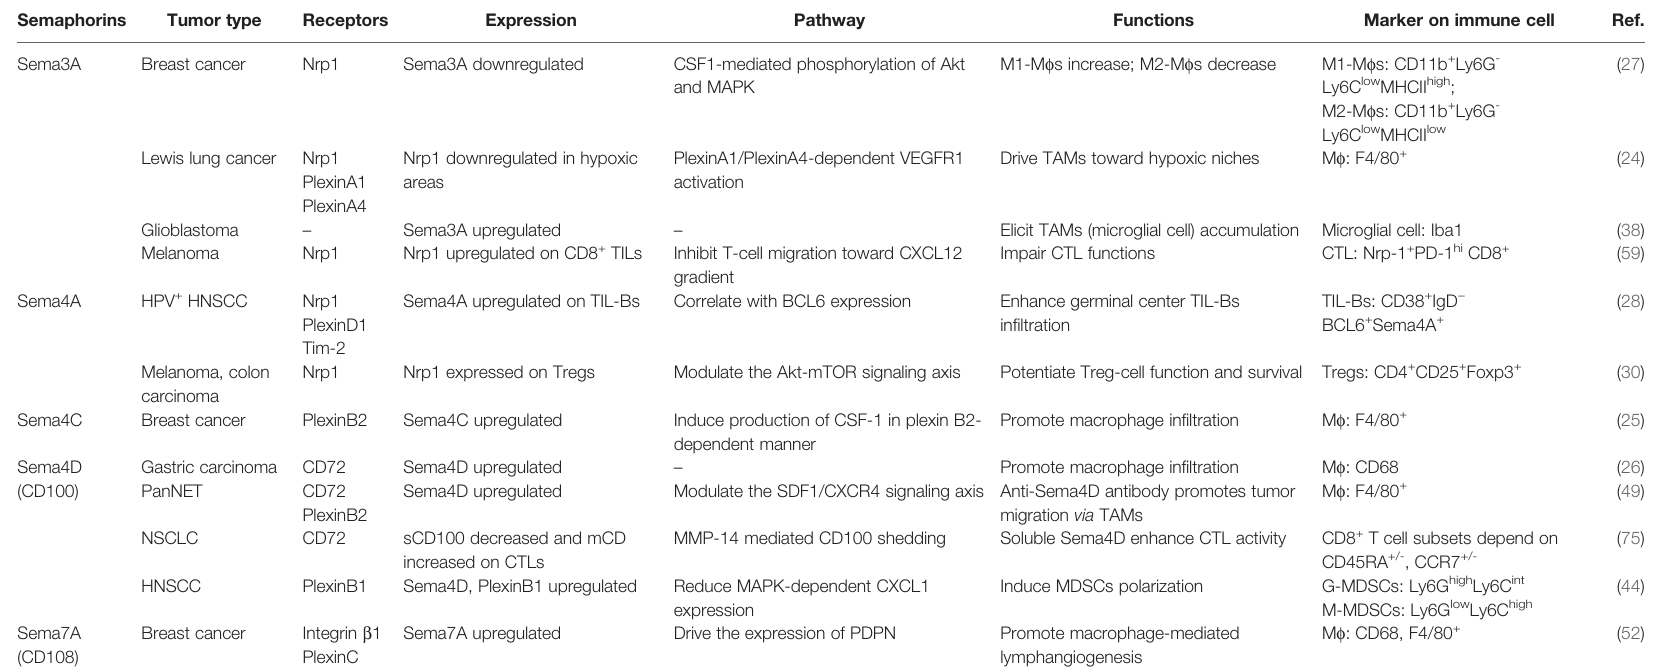
TABLE 1 | The roles of representative immune semaphorins in tumor